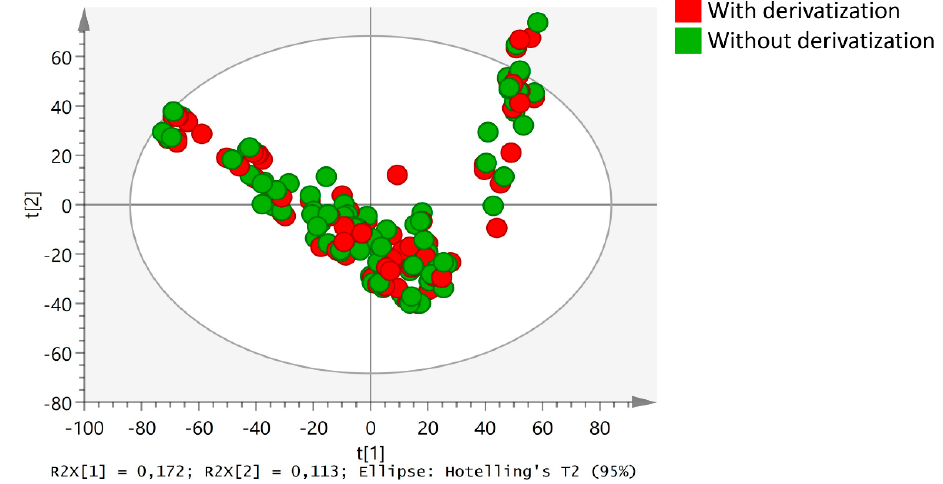
Figure 3. Principal component analysis of untargeted UHPLC ‐ QqTOF ‐ MS analysis of 92 wine samples with and without 4MeQ derivatization.